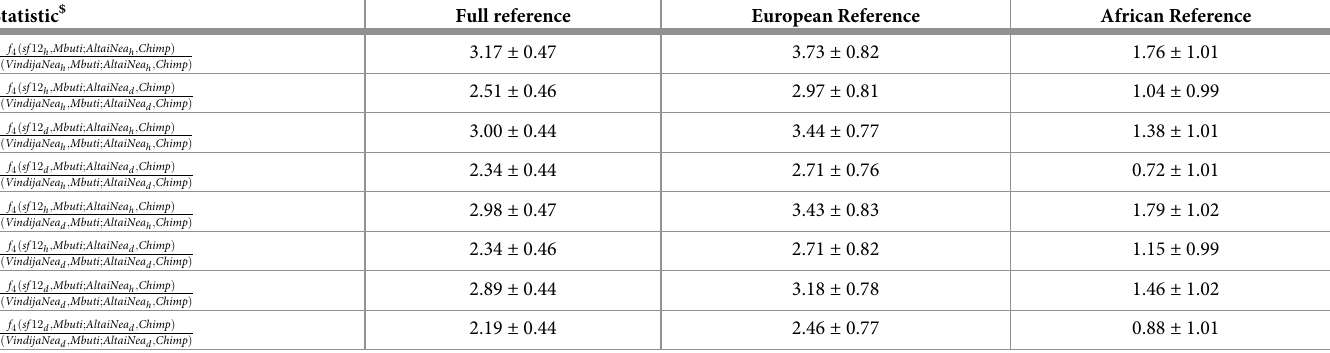
Table 3. Percentage of Neandertal ancestry (and standard errors) in sf12 using diploid and pseudo-haploid calls and different subsets of the human reference genome. Parts of the genome of East Asian origin were excluded due to their small total size. Statistic